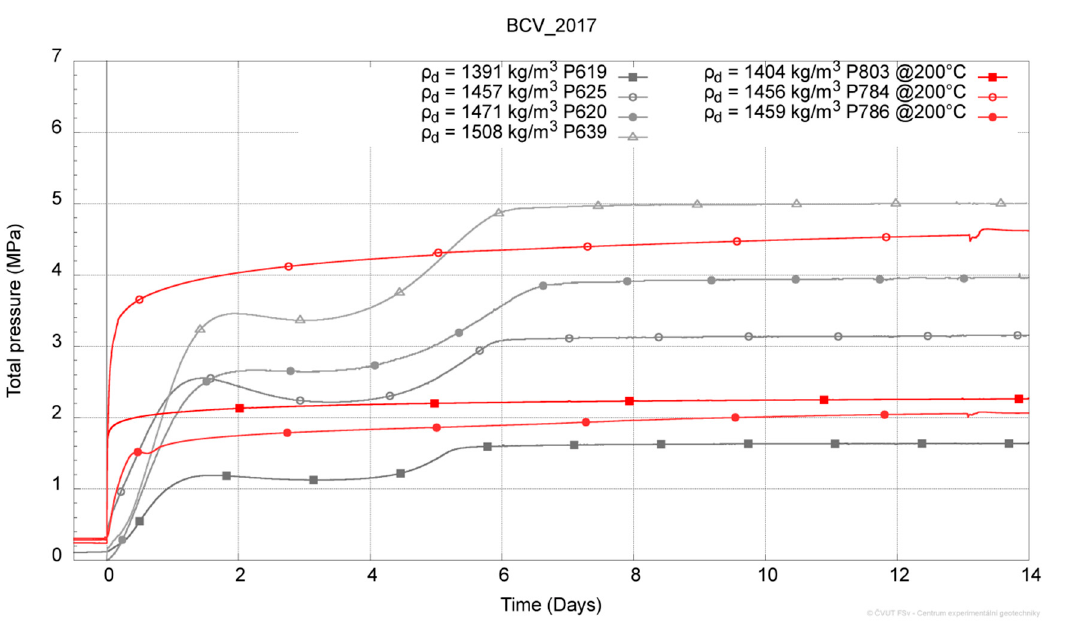
Figure 10. Evolution of the swelling pressure—the original material ( black ) and the thermally treated ( red ) materials; dry density of approx. 1400–1500 kg · m − 3 .